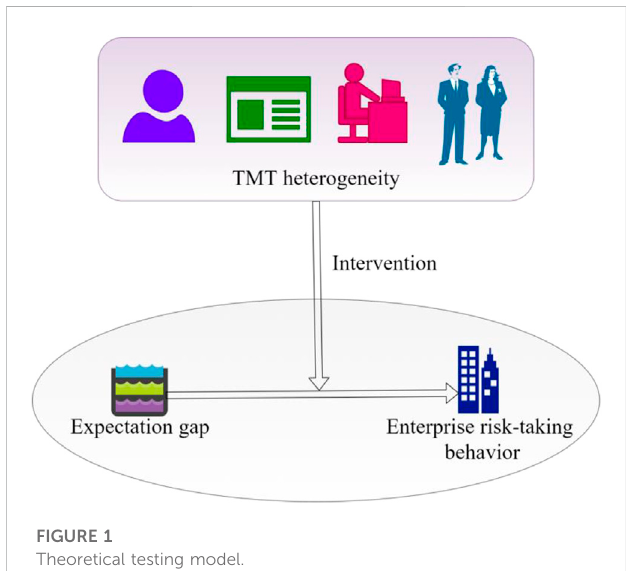
FIGURE 1 Theoretical testing